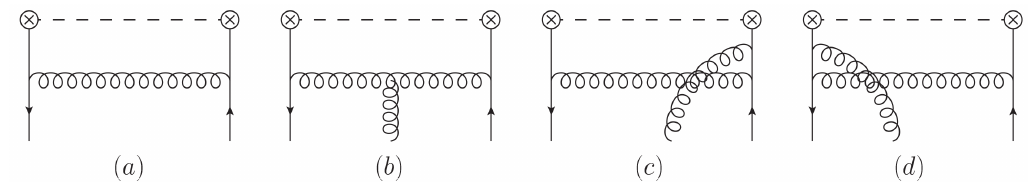
Figure 1 . Diagrams computed in this appendix. The external lines represent the background fields. The crossed blobs connected by the dashed line represent the quasidistribution